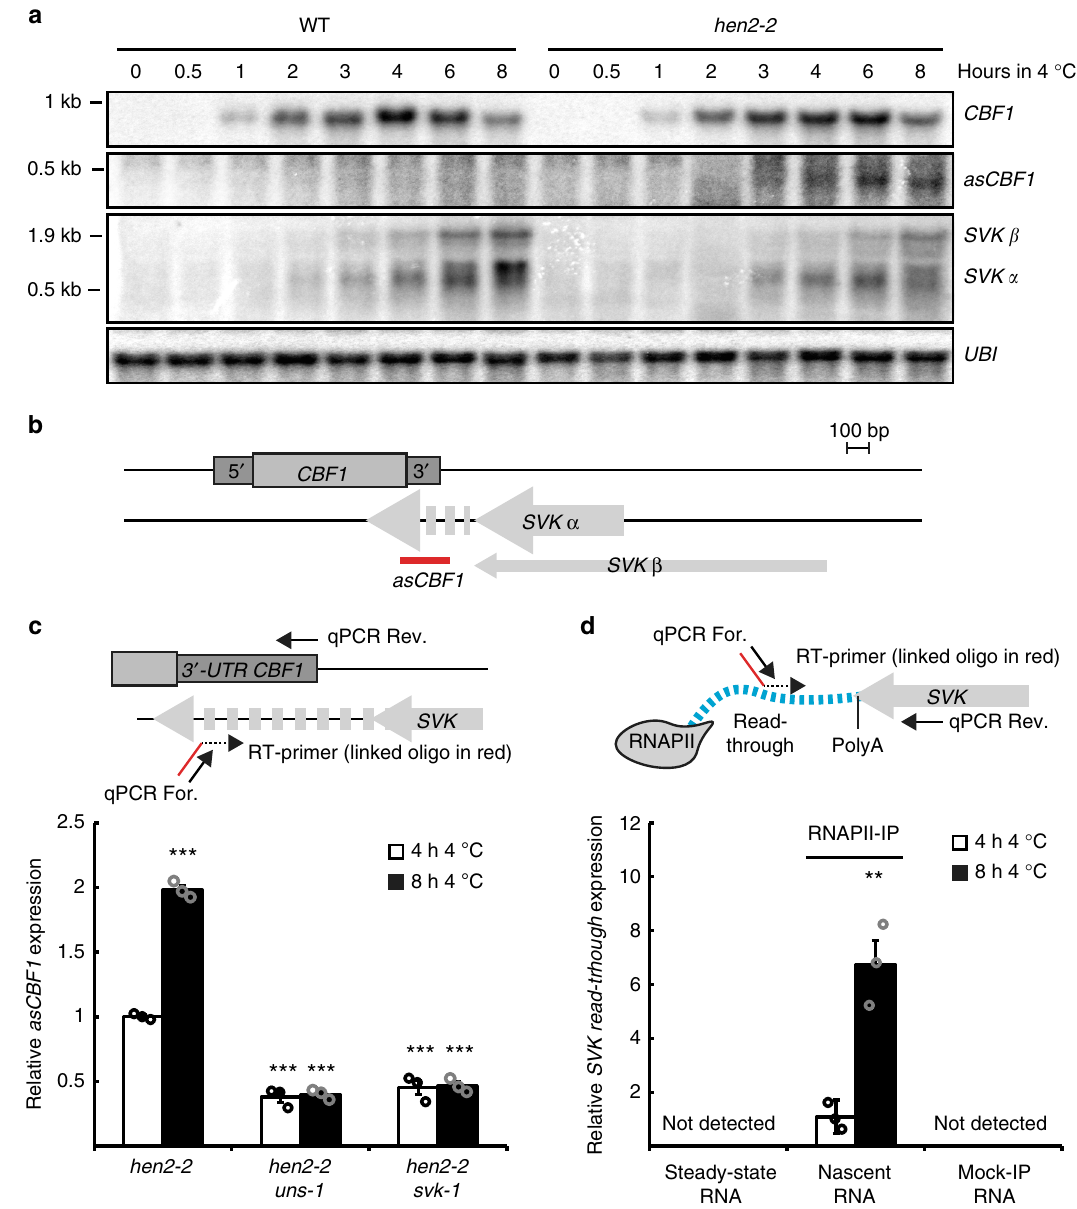
Fig. 4 SVALKA transcription mediates transcription activity antisense to CBF1 . a Representative Northern blot of a cold exposure time series of Col-0 (WT) and hen2-2 . The probe used for asCBF1 is shown in b . Blots were repeated with three biological replicates with similar results. UBI is used as loading control. Uncropped blots can be found in the Source Data fi le. b Graphical representation of the CBF1-SVK genomic region. The probe for asCBF1 is shown in red. RT was done with an oligo-linked primer to ensure strand-speci fi city and generated cDNA was used in c . c RT-qPCR of asCBF1 after cold exposure in hen2-2 and the double mutants, hen2-2uns-1, and hen2-2svk-1 . The RT-primer and the qPCR primers are shown in the graphical representation above the graph. Bars represent mean (white: 4 h 4 °C, black: 8 h 4 °C, ±SEM) from three biological replicates (rings). The relative level of asCBF1 was normalized to the level in hen2-2 after 4 h of 4 °C. Statistically signi fi cant differences were determined with Student ’ s t -test (*** p < 0.001). Source data are provided as a Source Data fi le. d ) RT-qPCR of SVK read-through transcripts. Hundred nanograms of RNA from an RNAPII-IP (i.e. RNA attached to RNAPII) or total RNA was converted to cDNA with an oligo-linked primer. The RT-primer and qPCR primers used can be seen in the graphical representation above the graph. The RT-primer annealed to a sequence downstream of the PolyA signal of SVK . A read-through transcript can be detected in the nascent RNA samples with an increased expression after 8 h of cold exposure. No signal could be seen in the Mock-IP or total RNA sample. Each bar represents the mean (white: 4 h 4 °C, black: 8 h 4 °C, ±SEM) from three biological replicates (rings). The relative level of read-through transcripts was normalized to the level in the nascent sample after 4 h of 4 °C. Statistically signi fi cant differences were determined with Student ’ s t -test (*** p < 0.001). Source data are provided as a